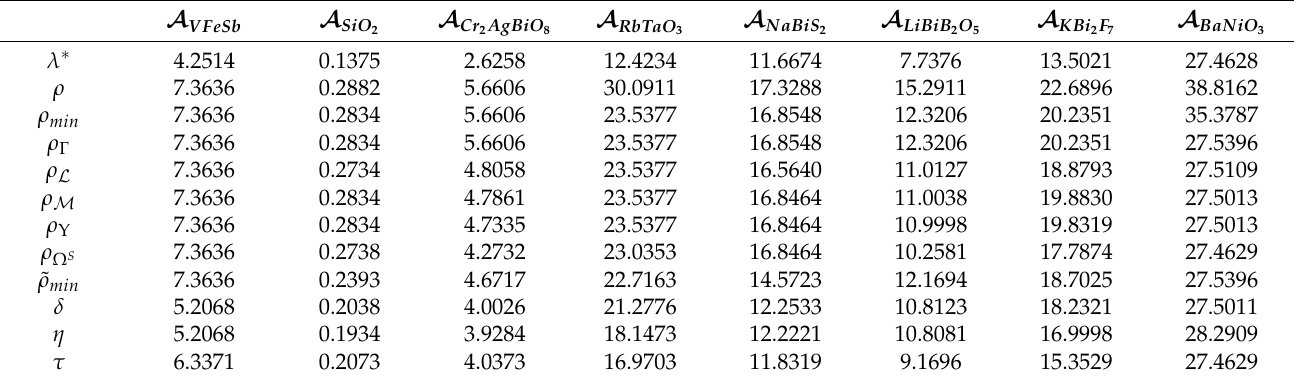
Table 1. Comparisons among Li’s method [12], Che’s method [13], Xiong’s method [16], He’s method [14], Liu’s method [15] and our